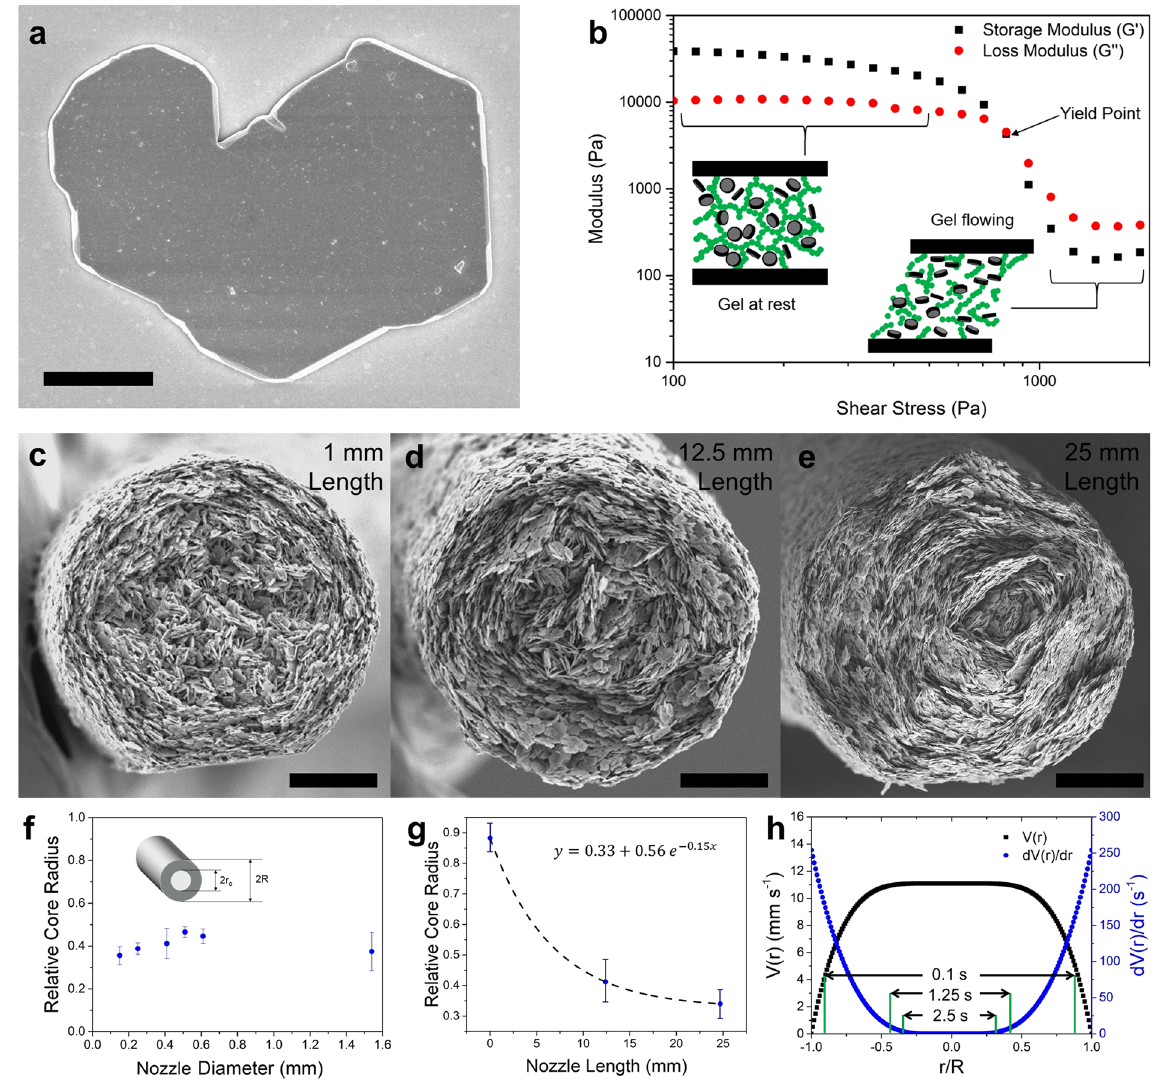
Figure 1. Rheology of platelet pastes and platelet alignment during extrusion. ( a ) SEM image of a single alumina platelet. Scale bar 2 μ m. ( b ) Dynamic mechanical analysis of the platelet laden printing paste, showing the paste stiffness and yield stress. ( c , d , e ) SEM images of filaments printed using different nozzle lengths, showing the effect of nozzle length on the level of concentric platelet alignment. Scale bars 30 μ m. ( f ) Measured relative core radius plotted against the nozzle radius, demonstrating invariance. ( g ) Measured core radius plotted against nozzle length, showing an exponential relationship. ( h ) Velocity profile, V ( r ), and velocity gradient, dV ( r ) /d ( r ) across a 0.41mm nozzle, computed using Equations 2 and 3. The experimentally measured core diameters are marked after the paste is subject to the velocity gradient for three amounts of time, corresponding to the three lengths of printing nozzles (1mm nozzle: 0.1 s, 12.5 mm nozzle: 1.25 s, 25 mm nozzle: 2.5